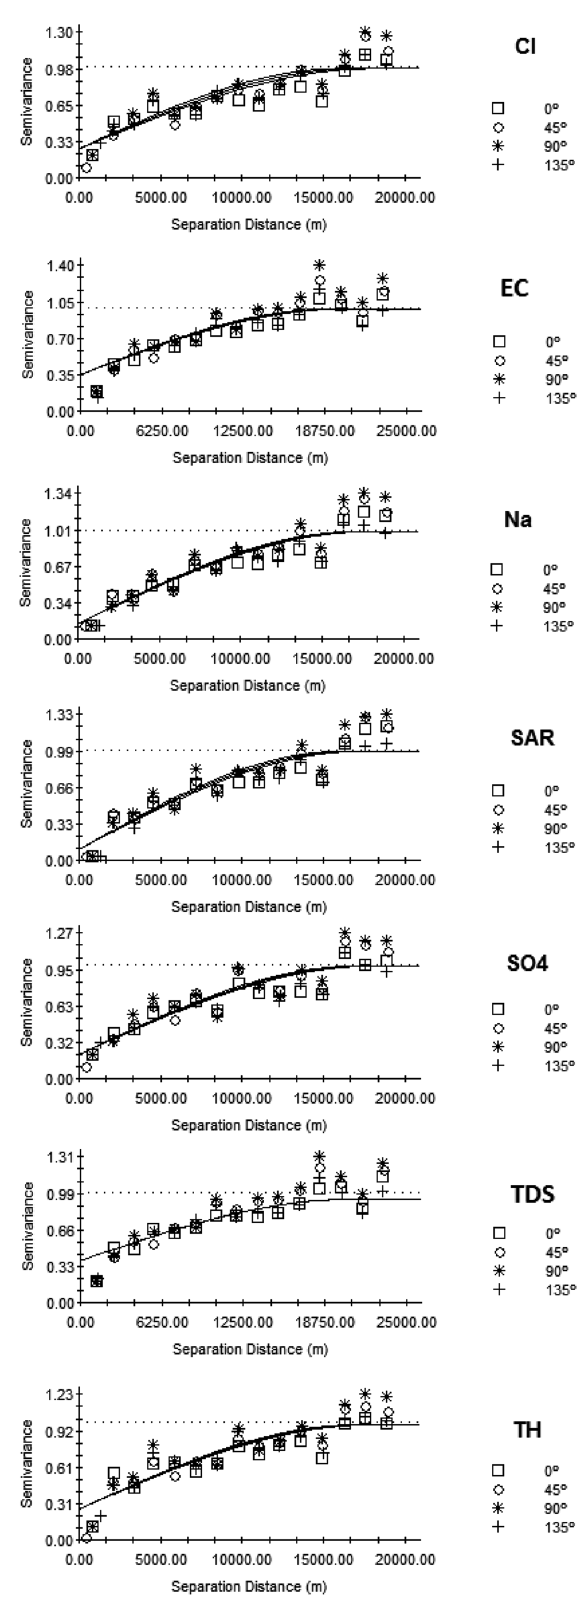
Fig. 2 Directional variograms of the quality